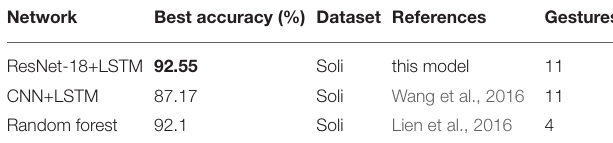
TABLE 3 | State-of-the-art radar-based gesture recognition. Network